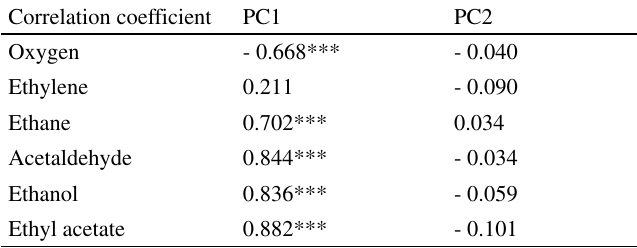
Table 2 - Linear correlation coefficients (r) of PC1 and PC2 scores, ob- tained from Principal Component Analysis, with oxygen lev- el, ethylene, and ethane amounts and fermentative metabolites Correlation